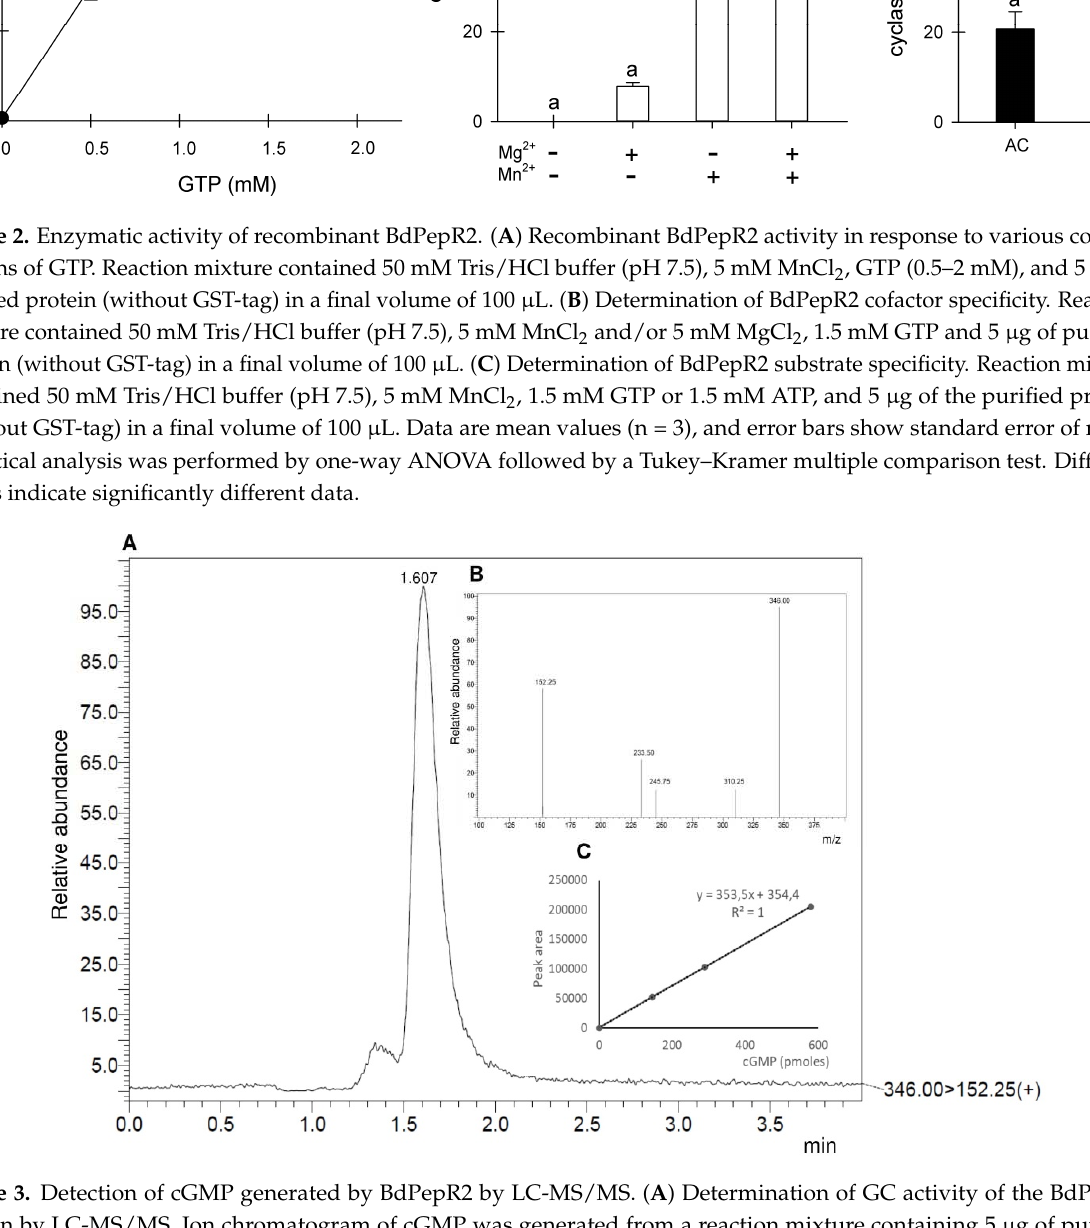
Figure 3. Detection of cGMP generated by BdPepR2 by LC-MS/MS. ( A ) Determination of GC activity of the BdPepR2 protein by LC-MS/MS. Ion chromatogram of cGMP was generated from a reaction mixture containing 5 µ g of purified protein and GTP as a substrate in the presence of 5 mM Mn 2+ . ( B ) Inset showing parent cGMP ion at m / z 346.00 [M + H]+ and corresponding fragmented daughter ion at m / z 125.25 [M + H]+. Fragmented product ion was used for quantitation. ( C ) Inset showing the cGMP calibration curve performed with 0–0.58 pmoles of pure cGMP on the column.